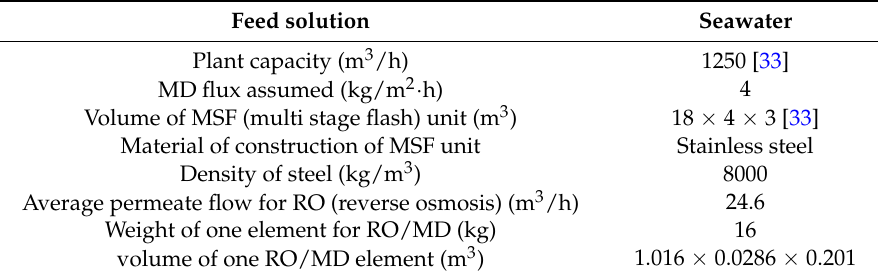
Figure 6. PI (process intensification) metrics for MD, multi stage flash (MSF), and RO. MI, mass intensity; PW, productivity/weight ratio; PS, productivity/size ratio. Table 1. Parameters and assumption used in calculation of various PI (process intensification) metrics shown in Figure 6.